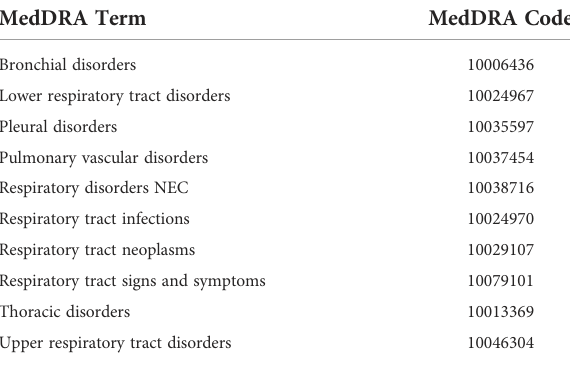
TABLE 1 Respiratory system event groups according to MedDRA